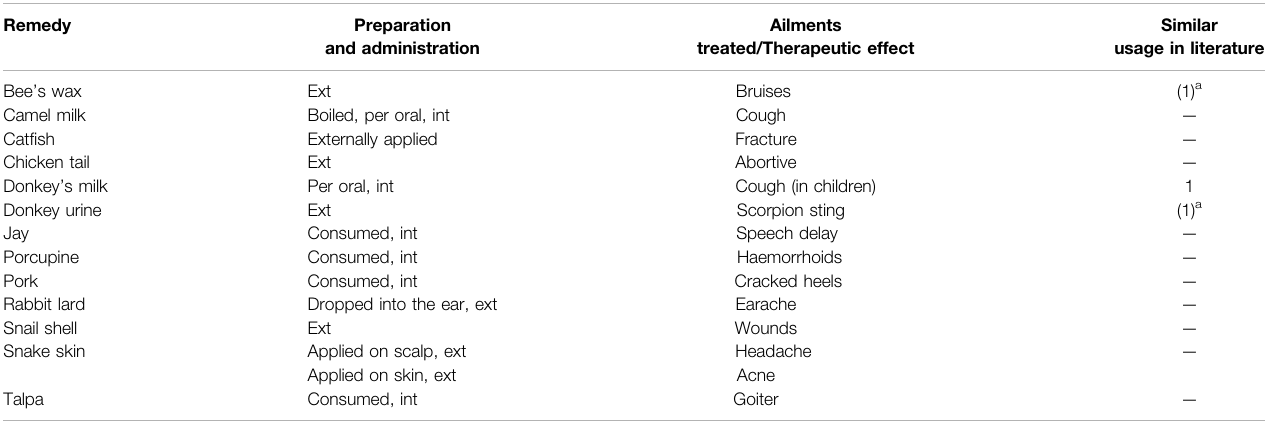
TABLE 6 | Animal-based folk remedies used in Mersin for treating human diseases.